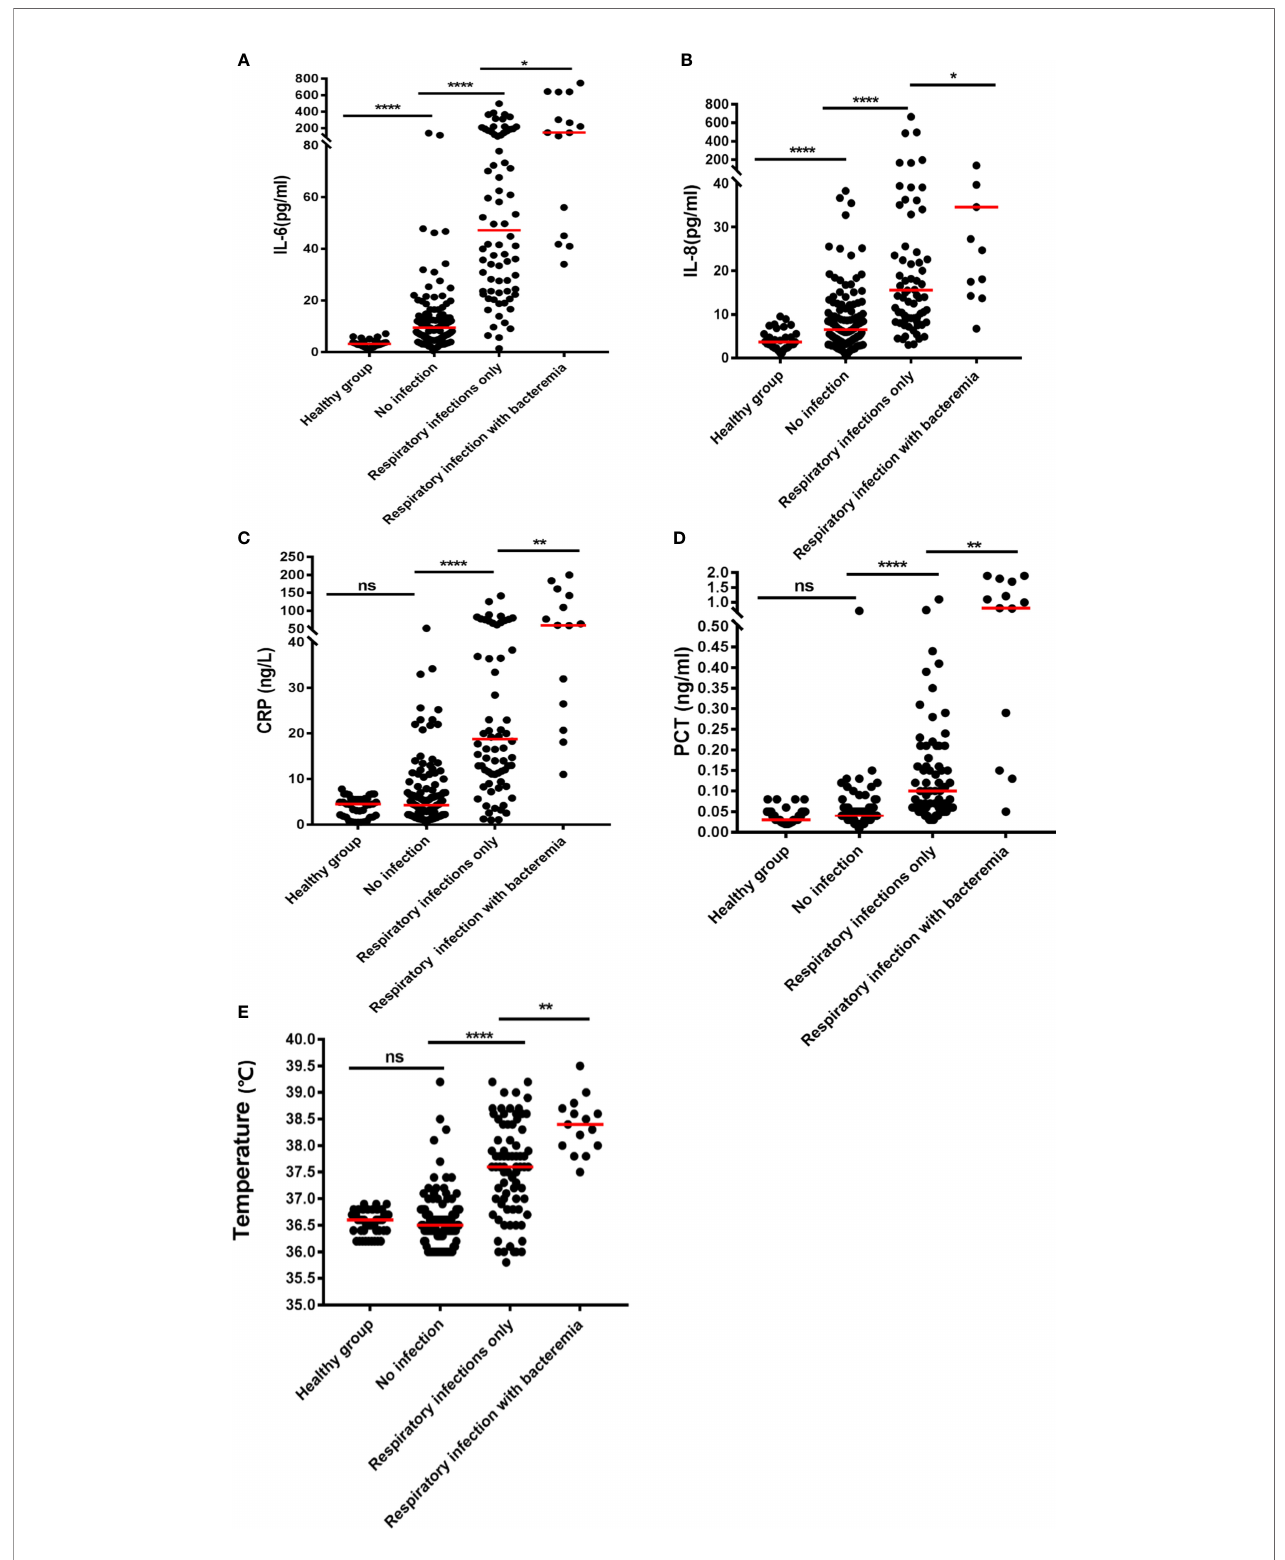
FIGURE 1 | Plots of the levels of in fl ammatory biomarkers in NHL patients with various forms of infection: (A) IL-6, (B) IL-8, (C) CRP, (D) PCT, and (E) temperature. The median is shown by the horizontal lines. * P < 0.05; ** P < 0.01; **** P < 0.0001; (ns) Not signi fi